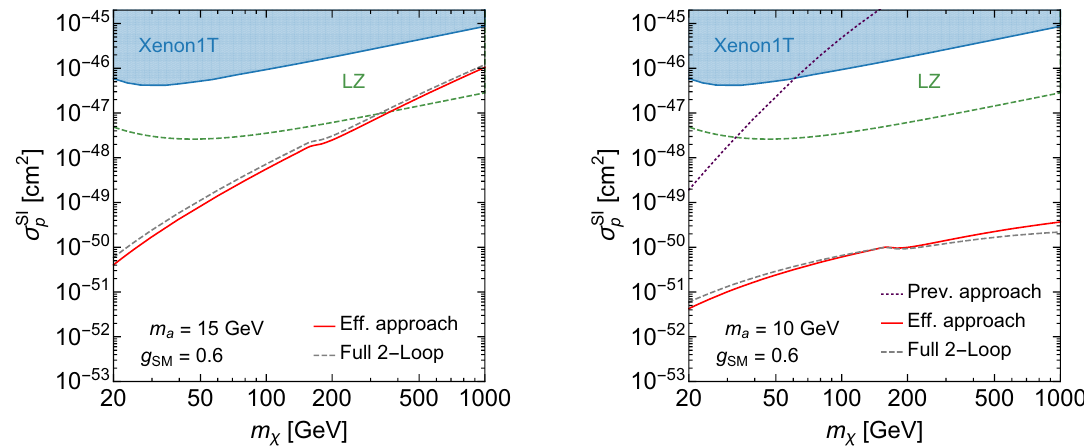
Figure 8 . Comparison of the e(cid:11)ective approach and the full two-loop result for two benchmark points in m (cid:31) (cid:27) SI plane. In the left panel we consider maximal CP violation with (cid:30) SM = (cid:25)= 2 p (cid:0) (cid:0) and (cid:30) (cid:31) = 0, whereas in the right panel we (cid:12)x (cid:30) SM = (cid:30) (cid:31) = (cid:25)= 2, i.e. pure pseudoscalar phases, and also show the curve corresponding to previous calculational approaches of the two-loop diagram. In both panels (cid:21) ah is set to zero and g (cid:31) is (cid:12)xed such that the correct relic density is reproduced. Note that additional contributions to the di(cid:11)erential event rate from momentum-dependent interactions at tree-level may lead to stronger exclusion limits than the ones shown in this